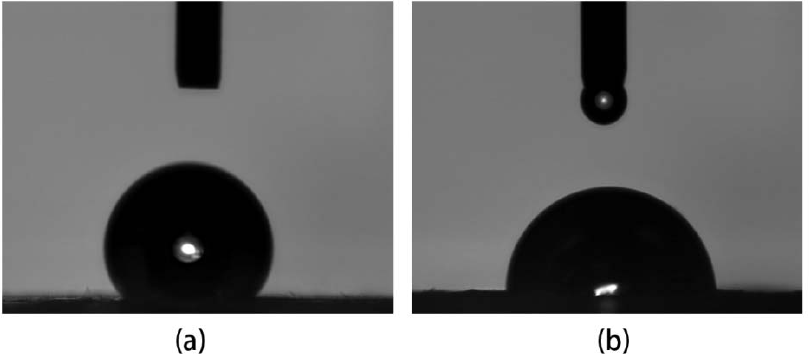
Figure 4. Water contact angle of ( a ) pure silk nanofibers; and ( b ) silk/TMOS